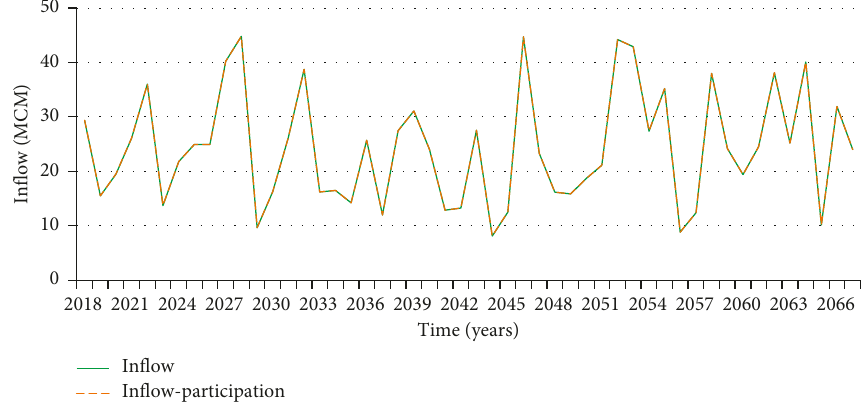
Figure 21: Future runoff into Huay Ling Jone